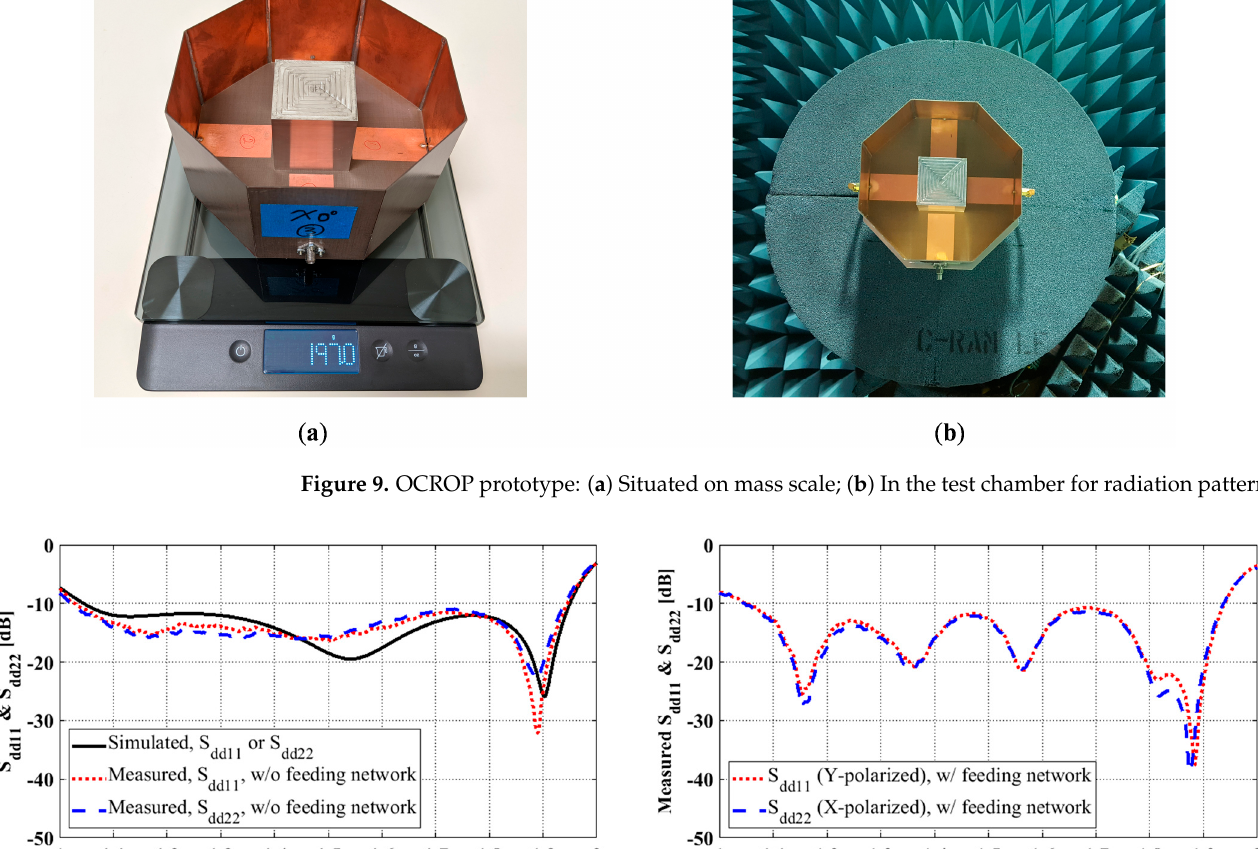
Figure 9. OCROP prototype: ( a ) Situated on mass scale; ( b ) In the test chamber for radiation pat- terns.